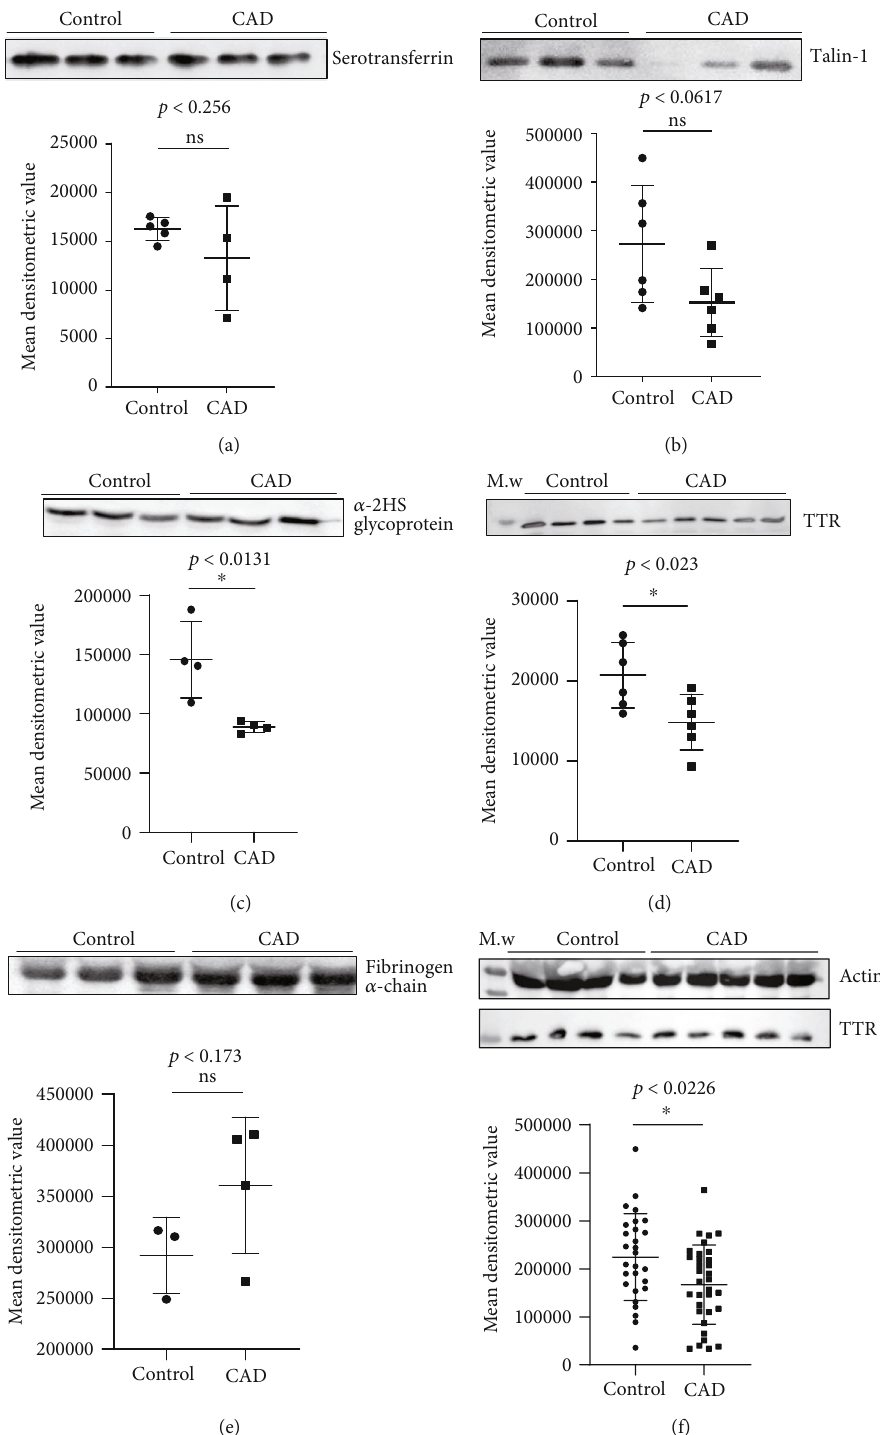
Figure 2: Validation of di ff erential protein level analysis in CAD plasma. Western blot analysis representing altered level of distinctly identi fi ed proteins from CAD plasma. Serotransferrin protein (a), Talin-1 protein (b), Alpha-2HS glycoprotein (c), and TTR (d) showed low level with a statistical di ff erence of 1.1-fold, p < 0 : 256 ; 1.45-fold, p < 0 : 0617 ; 1.31-fold, p < 0 : 0131 ; and 1.5-fold, p < 0 : 023 , respectively, in CAD ( n = 5 ) compared healthy control ( n = 5 in each). However, the fi brinogen- α chain protein (e) showed high level in CAD ( n = 5